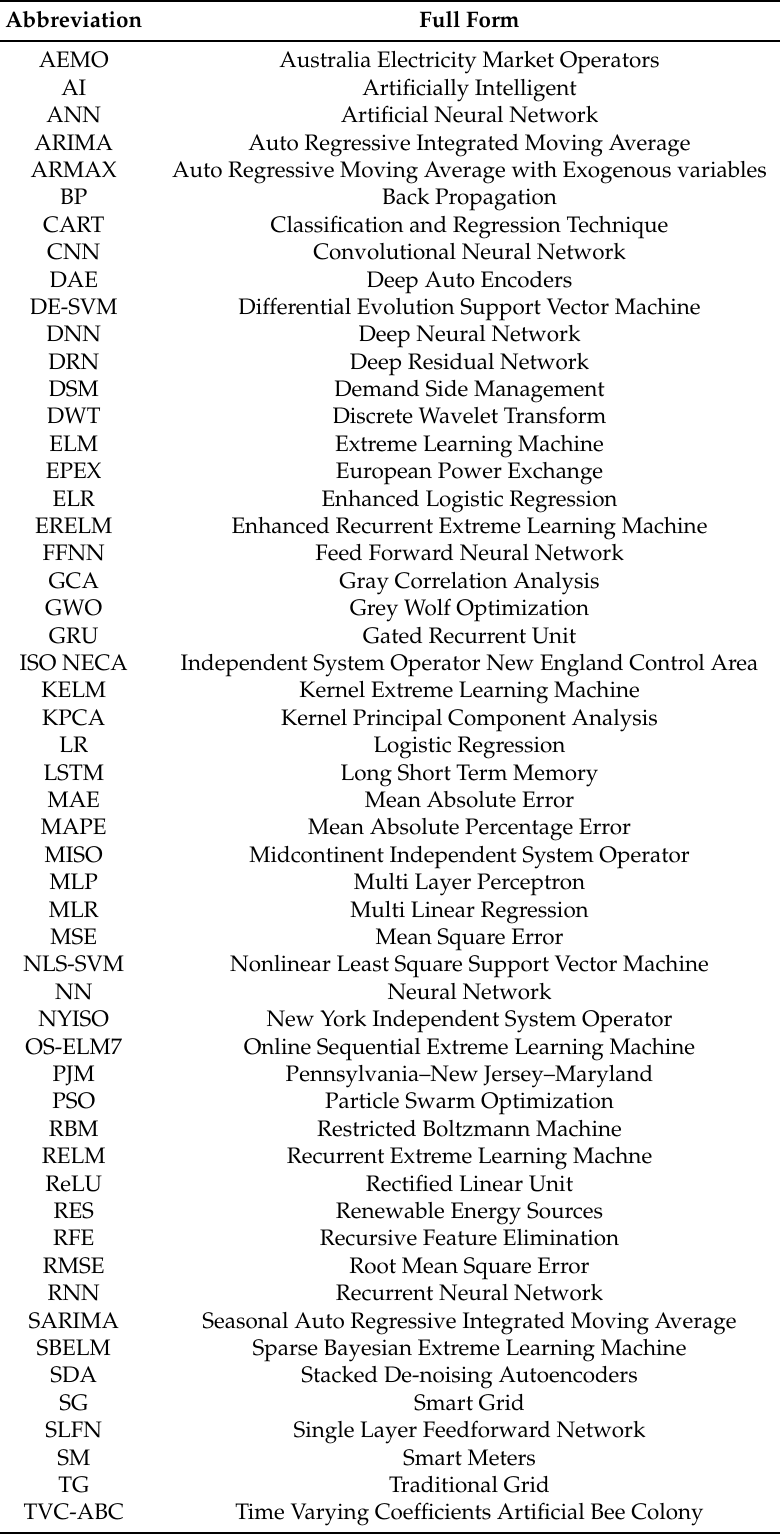
Table 2. List of